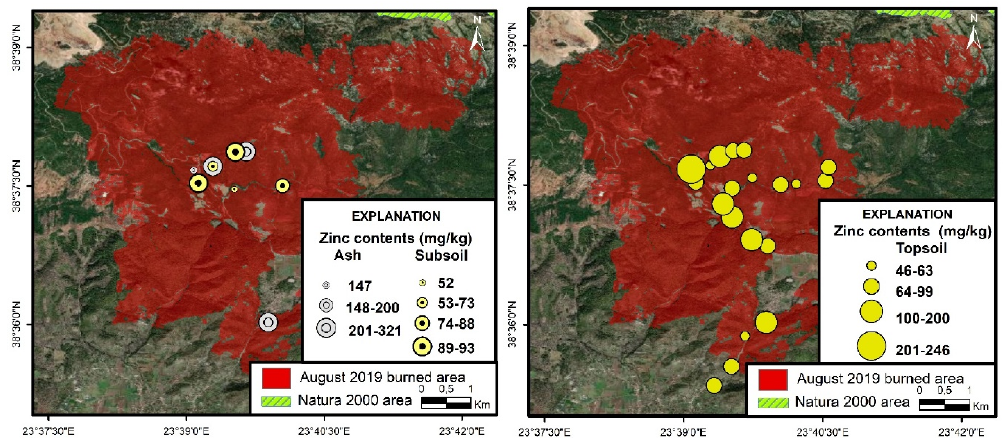
Figure 8. Map presenting zinc contents in ash, topsoil and subsoil at the area studied (modified from [23,24,26]).